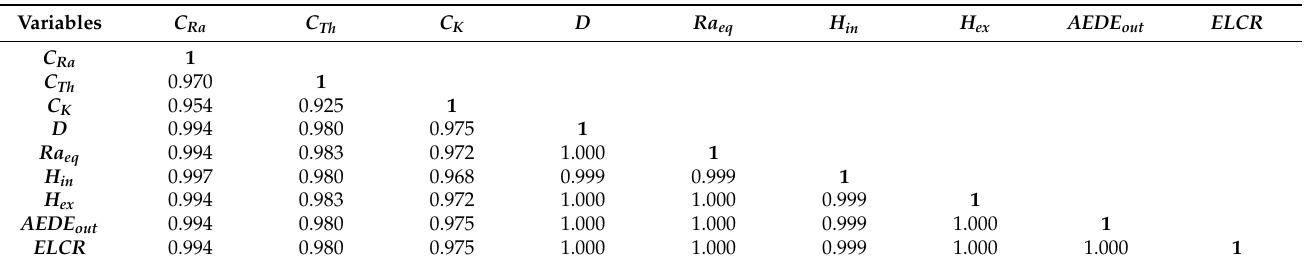
Table 7. Pearson’s correlation matrix.